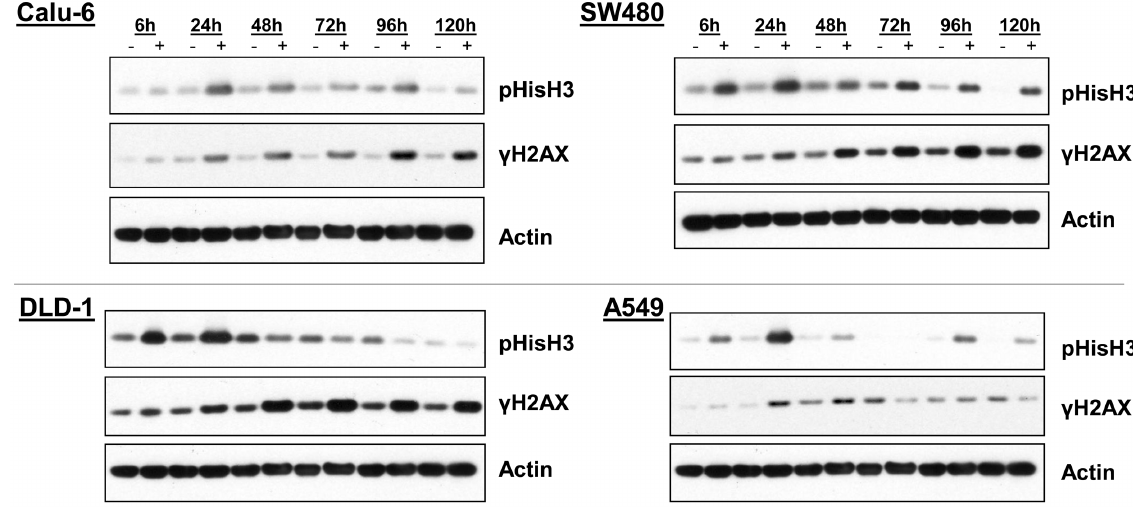
Figure 4. Plk1 inhibition leads to mitotic arrest and DNA damage in a wide range of human cancer cell lines. Cells were treated with MLN0905 (Calu-6, 10 nM; DLD-1, 90 nM; A549, 30 nM; SW480, 20 nM) for the indicated times and immunoblotting was used to monitor mitotic arrest (pHisH3) and DNA damage ( c H2AX).